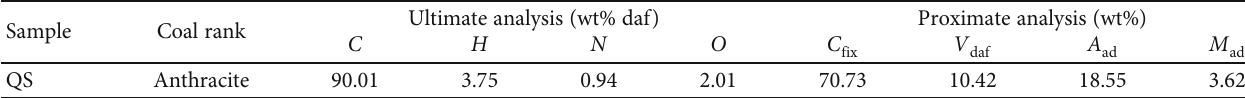
Table 2: Results of ultimate and proximate analyses of QS anthracite.